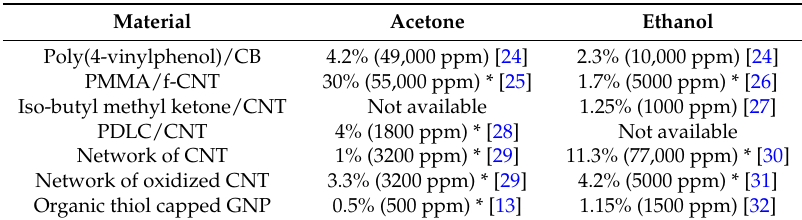
Table 1. Reported percentage of resistance change in response to ethanol and acetone for resistor based sensors at room temperature in different